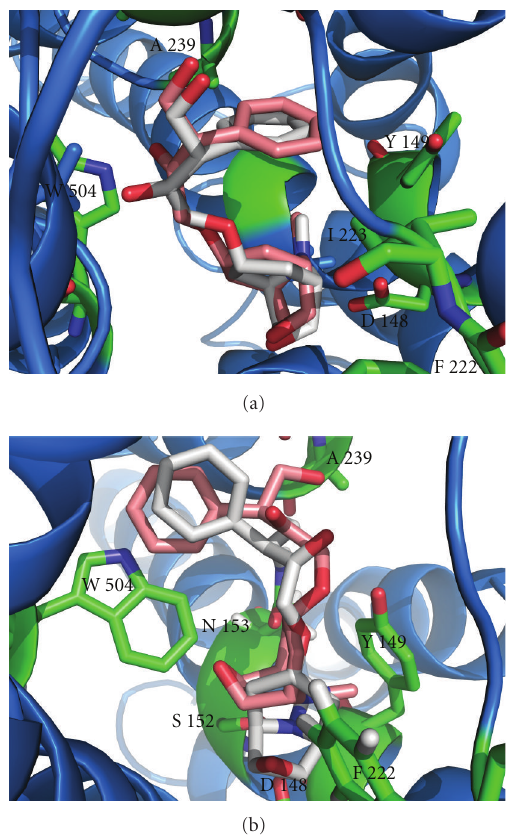
Figure 6: Di ff erent conformations that ligand exhibits in the two di ff erent simulations: POPC and POPC/POPS simulation. (a) Superposition of two snapshots of the POPC MD simulation at 15 and 40ns. (b) Superposition of two snapshots of the POPC/POPS simulation at 25 and 45